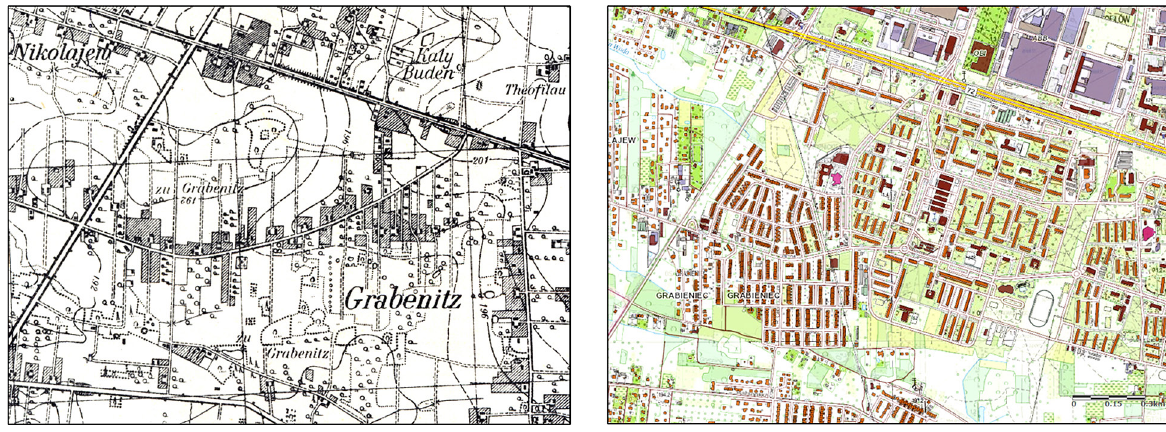
Fig. 6. Morphological changes in the former village Grabieniec.